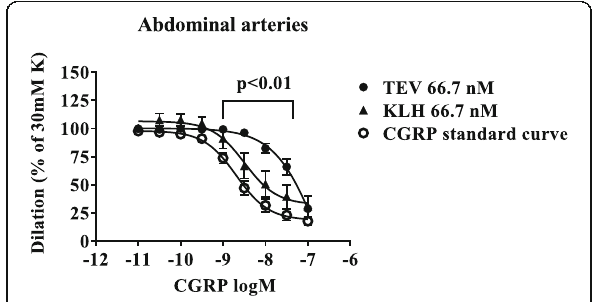
Fig. 1 Human abdominal subcutaneous arteries were pre-contracted with 30 mM potassium buffer. The curves show dilatation in response to increasing concentrations of α CGRP 10 − 11 to 10 − 7 M in the presence of 66.7 nM of the monoclonal antibody against CGRP (fremanezumab) or an isotype control (KLH). The data show mean±SEM, n =2 – 4 for each concentration. CGRP:calcitonin gene-related peptide; K:potassium; TEV:Teva